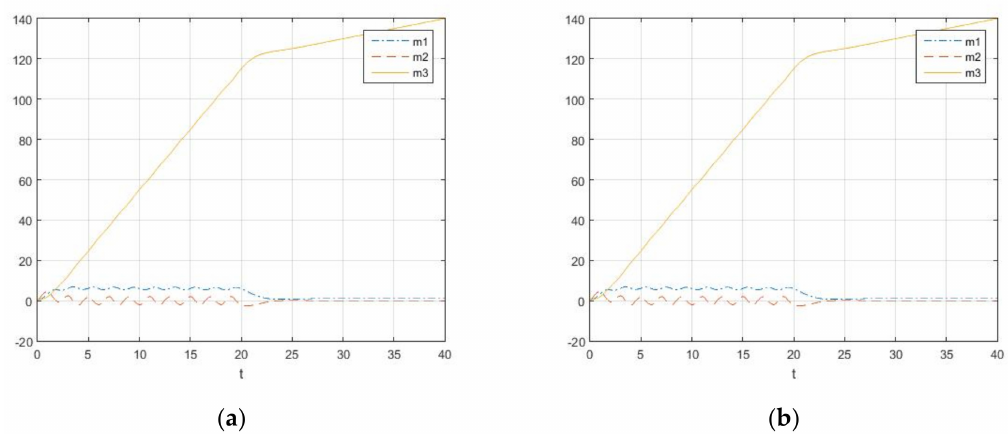
Figure 9. ( a ) Graphs m 1 , m 2 , m 3 at α = 0 ◦ , N = 10; ( b ) Graphs k 11 , k 22 , k 33 at α = 0 ◦ , N = 10.